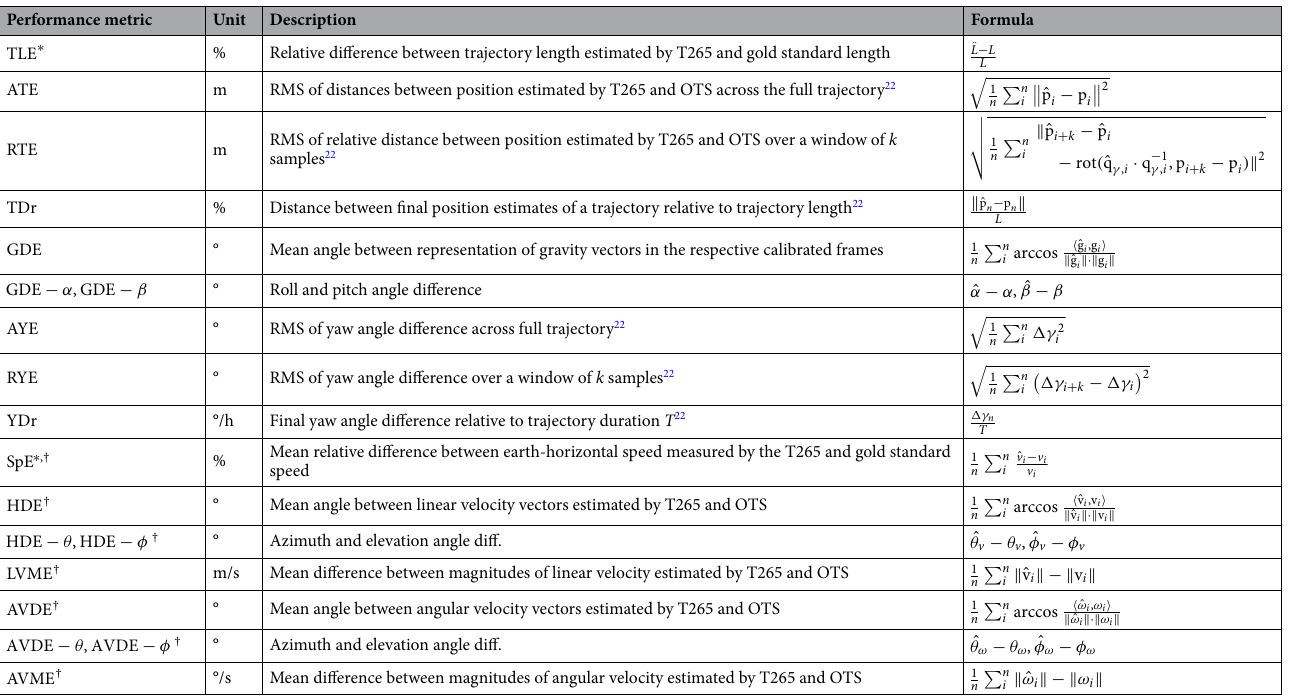
Table 1. Description of performance metrics. Metrics denoted with a star ( all other metrics only for the optical tracking space study. For metrics denoted with a dagger ( † ) we excluded samples where the gold-standard motion speed was below 0.1